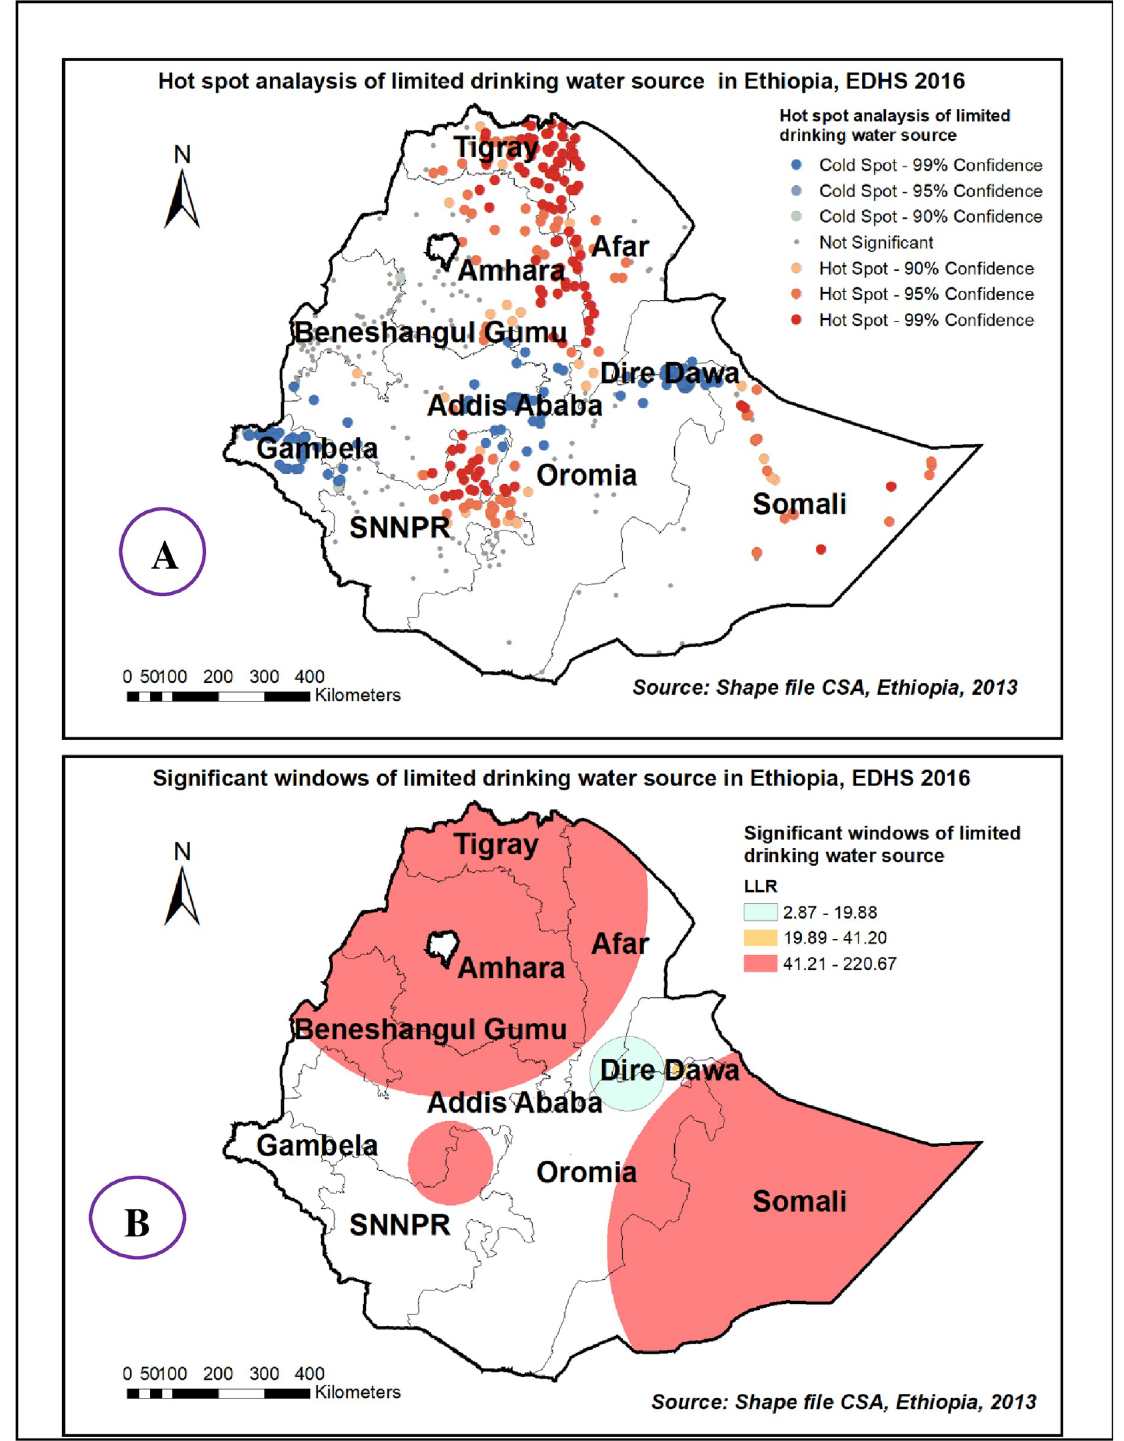
Fig 2. Hot spot areas (A) and significant windows (B) of limited drinking water source in Ethiopia, EDHS 2016, shapefile from 2018 GADM and plotted using ArcMap version 10.7 software.